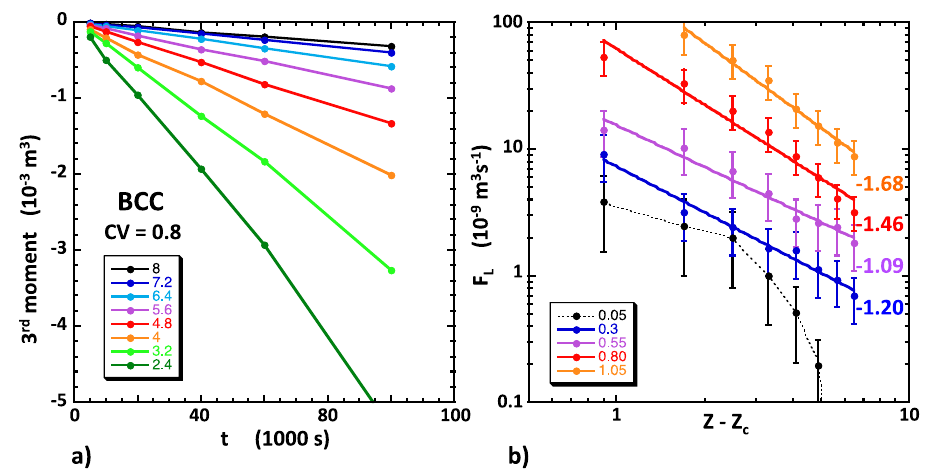
Figure 4. ( a ) Examples of the evolution with time of the simulated third moments M 3 ( t ). The data shown are averages of pairs of simulations in identical conditions (BCC, 50000 particles, CV = 0.80, U = 10 − 4 ms − 1 and Z between 3.2 and 8 as indicated by the colored symbols). ( b ) Relationship of the time rate coefficient F L and Z − Z c . For CV ≥ 0.3 the data obey approximate power laws, the exponents of which are indicated in matching colors. For CV = 0.05 a power law is not observed. The error bars represent the ensemble statistical fluctuations expected in these